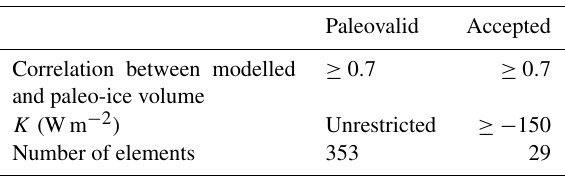
Table 3. Summary of Paleovalid and Accepted ensemble character- istics.